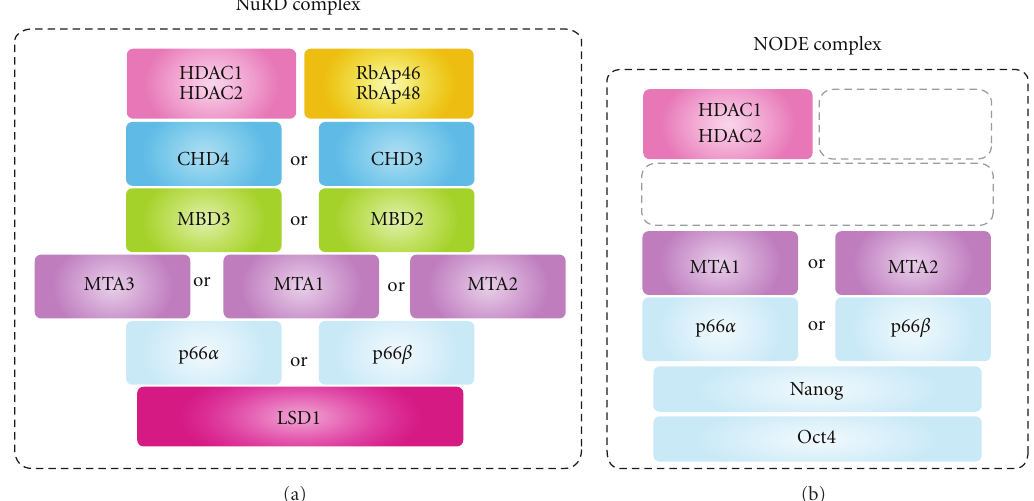
Figure 2: The NuRD complexes. Schematic representation of the NuRD complex (a) and ES cell-specific NODE complex (b). The empty dotted boxes indicate missing subunits compared with the NuRD